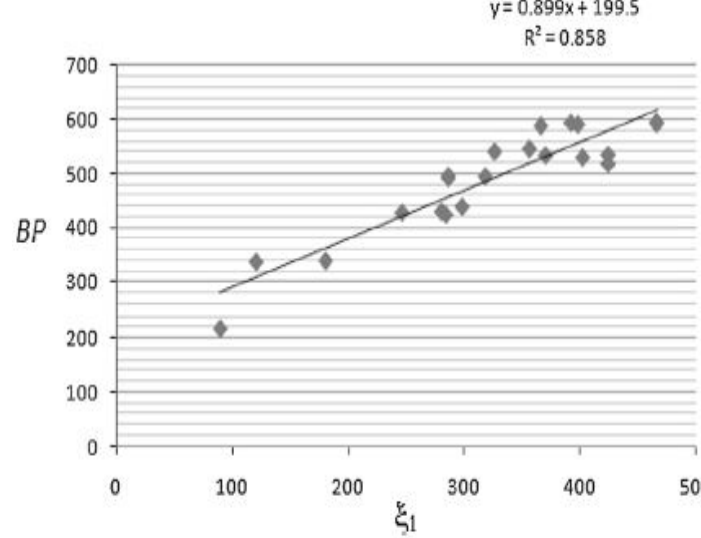
Figure 8. The scatter plot of BP and ξ 1 .